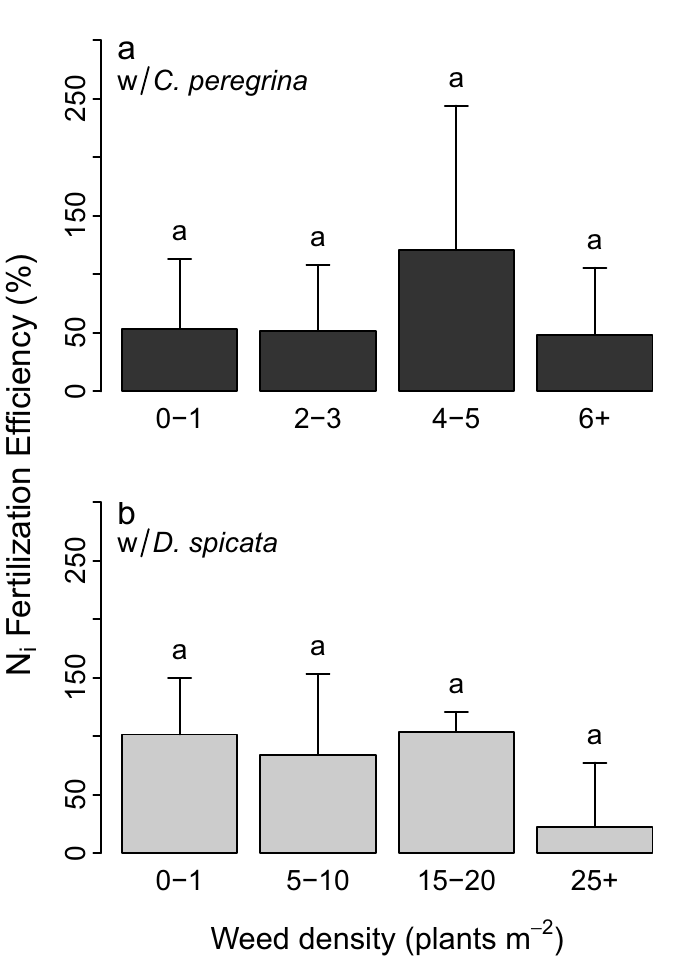
Fig 2. Increased fruit yield (%) due to the inorganic N treatment (inorganic N-fertilization efficiency) as a function of weed density. The increase in fruit yield was determined relative to fruit yield in control plots. (a) Inorganic N-fertilization efficiency in plots of C . peregrina ; (b) Inorganic N-fertilization efficiency in plots of D . spicata . Values are mean ± SD ( n = 3). Values that share the same letters above the bar plots are not significantly different ( P > 0.05). contrast, N-fertilization did not affect weed biomass (Table 1). Weed biomass was much higher in C . peregrina plots than in D . spicata plots under all N-fertilization treatments (Table 2). The significant interaction between weed species and weed density (Table 1) reflects the decrease in blueberry aboveground vegetative biomass with increased D . spicata density (Fig 4B), whereas no such trend was observed in plots having C . peregrina (Fig 4A). The fertili- zation treatments did not significantly affect the blueberry fruit yield: aboveground vegetative biomass ratio. In contrast, this ratio was significantly higher in plots having D . spicata than those with C . peregrina for all fertilization treatments (Table 2).